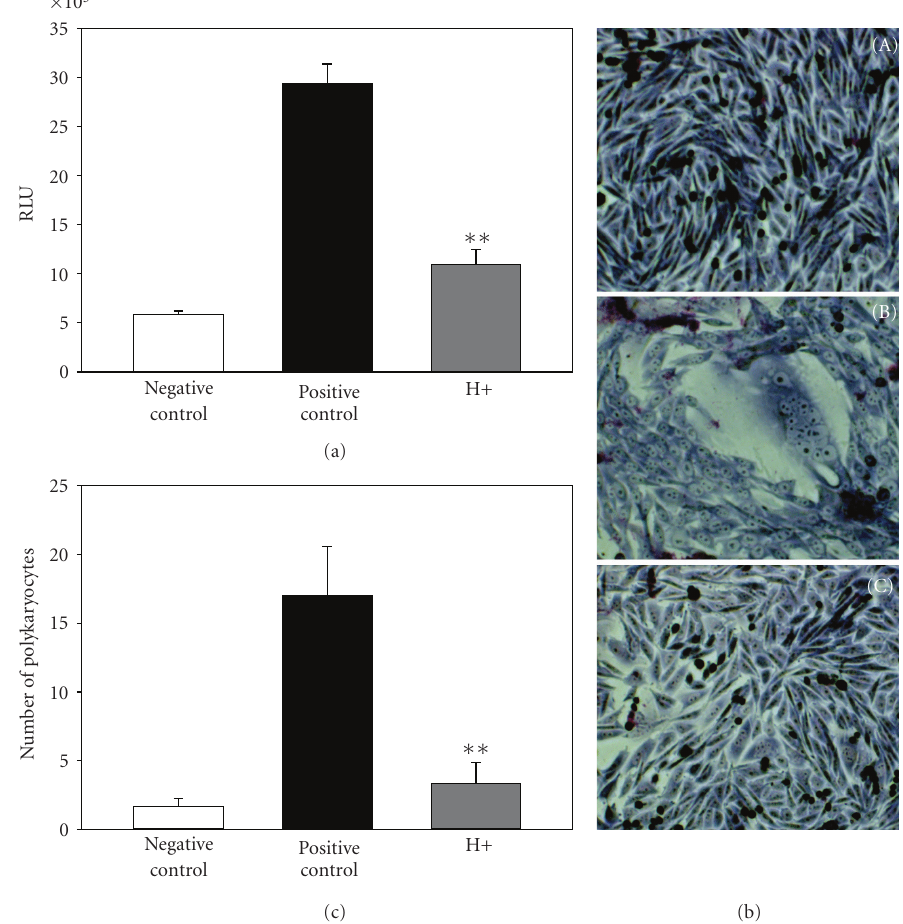
Figure 6: E ff ect of heparinase on quantitative HSV-1 glycoprotein-induced fusion with hMSCs. (a) In this experiment, the e ff ector CHO- K1 cells were transfected with HSV-1 glycoproteins gB, gD, gH, and gL, and T7 RNA polymerase. The target hMSCs were transfected with plasmids expressing luciferase reporter gene. A luciferase reporter assay was performed 24 h after the two cell populations were mixed together. Cell fusion was measured in relative luciferase units (RLUs). Expression of gD receptors in hMSCs results in the fusion of CHO-K1 cells with HSV-1 glycoprotein expressing cells (black bar), while in a negative control coculture of target cells with e ff ector cells devoid of all four glycoproteins-encoding genes, no luciferase activity was recorded (white bar). Coculture of heparinase (H+) pretreated-target cells with e ff ector cells resulted in significant decrease in cell fusion (grey bar). (b). The e ff ects of heparinase on multinucleated polykaryocytes formation were visualized. Multinucleated cells or polykaryocytes were microscopically observed with the hMSC target cells cocultured with e ff ector CHO-K1 cells expressing HSV-1 glycoproteins (panel (B)) but not with CHO-K1 cells expressing control vector pDream2.1 (panel (A)) or with the pretreatment of target hMSCs with heparinase-I (1.5U mL − 1 ) before mixing with e ff ector cells (panel (C)). Both type of cells were cocultured and stained with Giemsa at 24 h postmixing. Shown are photographs of representative cells (Olympus IX50 inverted microscope) after 24h postmixing. (c) Quantitative determination of the number of fused polykaryocytes formed after coculture of target hMSCs cocultured with the e ff ector CHO-K1 cells expressing HSV-1 glycoproteins in presence (grey bar) or absence (black bar) of heparinase. E ff ector CHO-K1 cells expressing empty vector (pCDNA3.1) cultured with target hMSCs was used as a negative control (white bar). The data shown are the means of triplicate measures with three independent experiments. Asterisks indicate significant di ff erence from other treatments ( ∗∗ P < . 01, t test), and error bars represent standard deviation